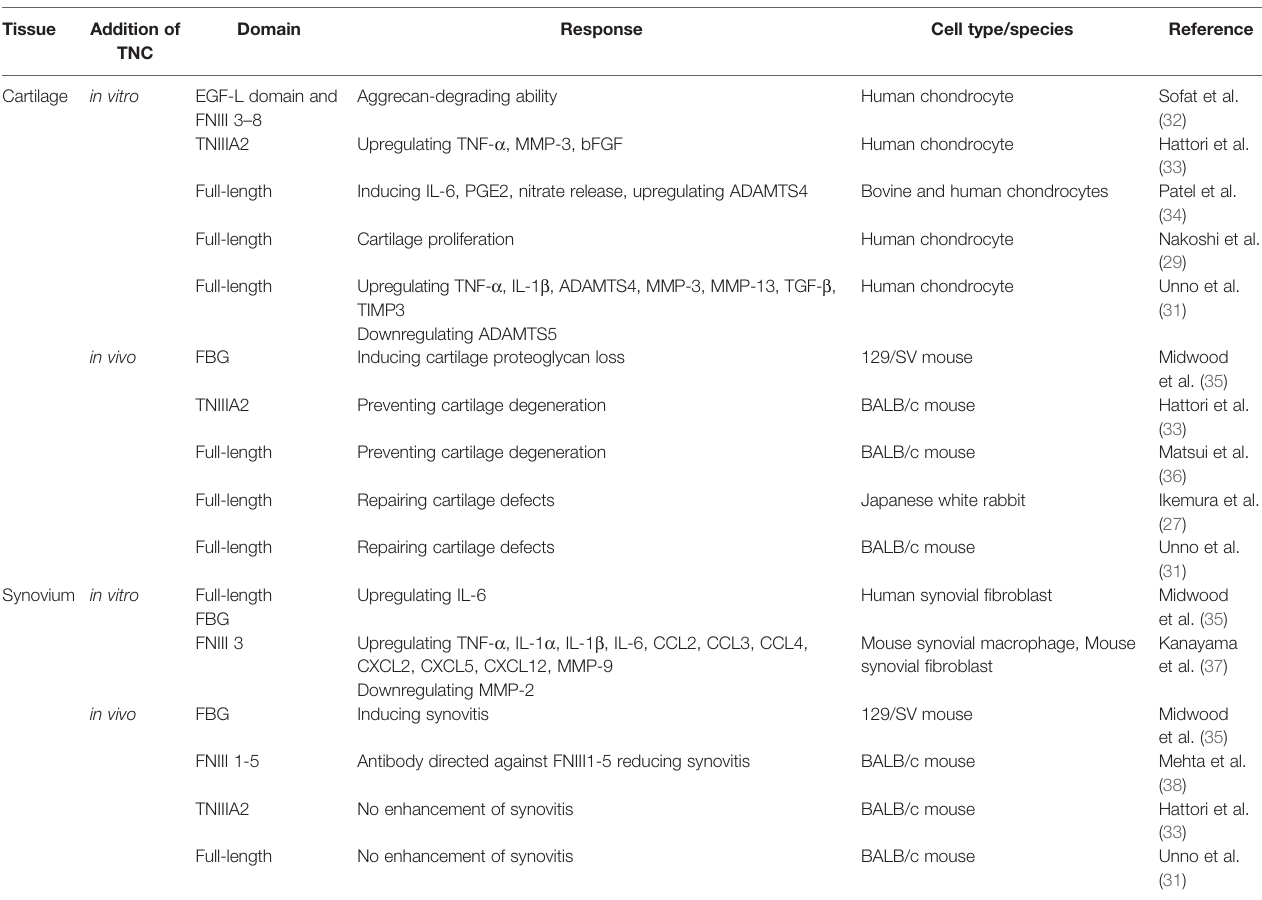
TABLE 1 | Effect of tenascin-C domain on cartilage and synovial